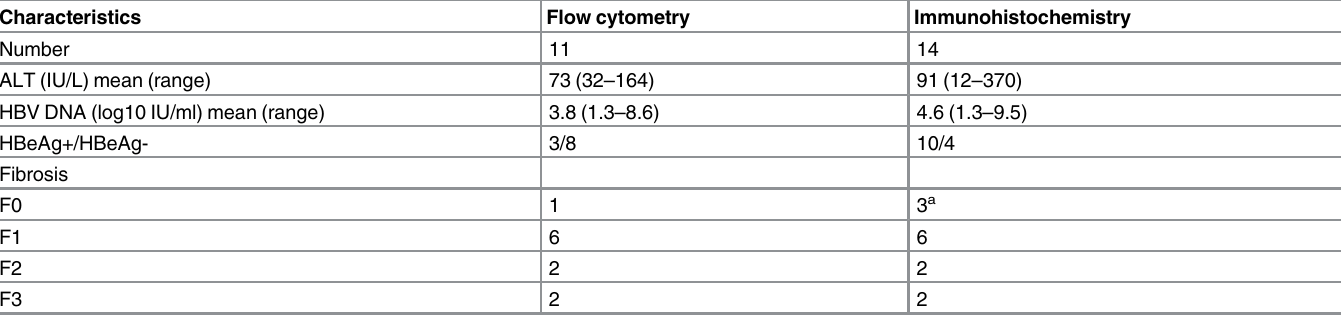
Table 2. Characteristics of donors used for intrahepatic DC